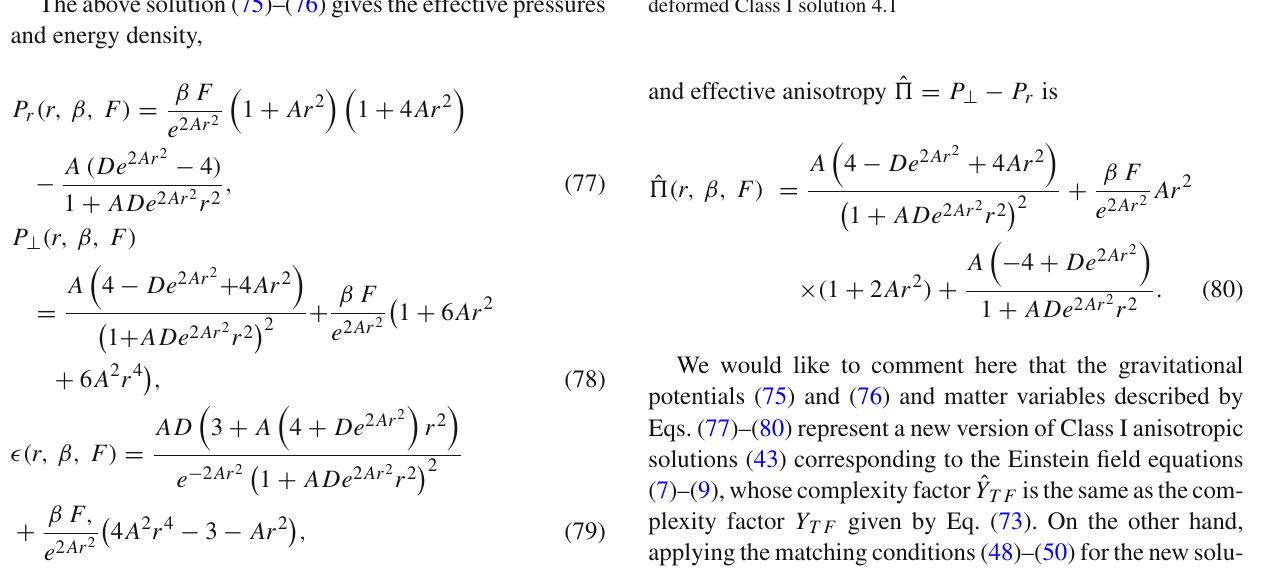
Fig. 4 Thebehaviorofthecomplexityfactor ( ˆ Y TF × 10 4 ) versusradial coordinate r / R for different coupling constant β with compactness fac- = 0 . 25. This complexity figure is plotted for the minimally tor M s R deformed Class I solution